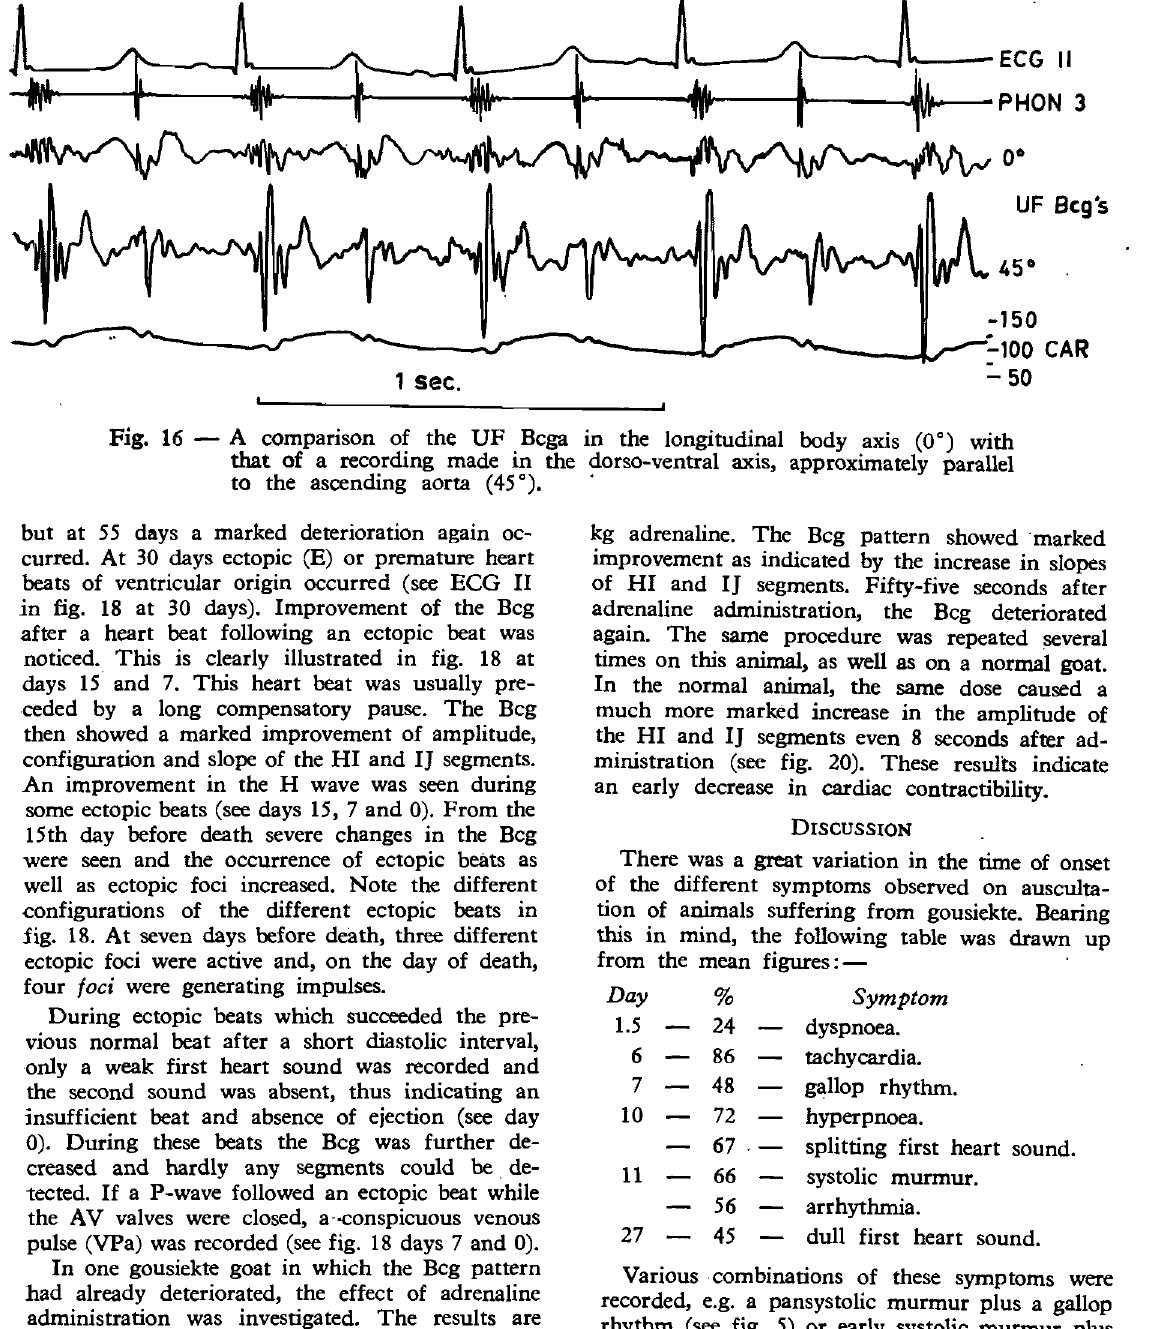
fig. 18. At seven days before death, three different ectopic foci were active and, on the day of death, four foci were generating